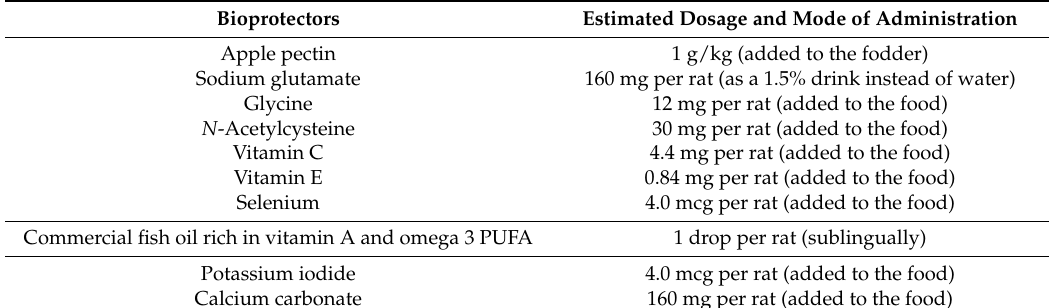
Table 13. Doses and Mode of Administration of the Bioprotectors Tested in Our